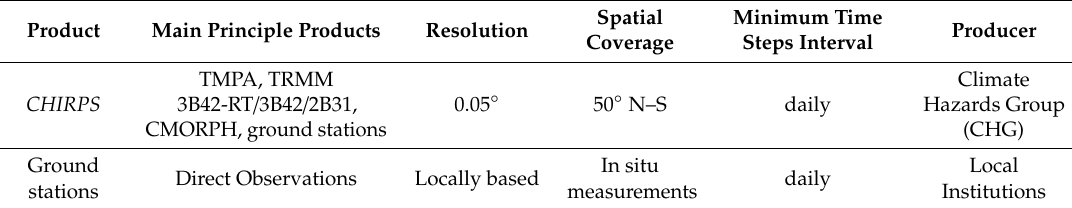
Table 1. Climate Hazards Group InfraRed Precipitation with Station data ( CHIRPS ) and ground station